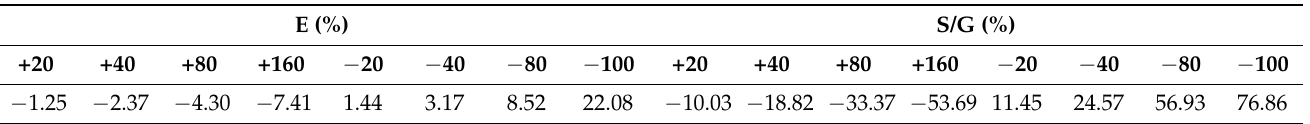
Figure 13. Changing rates of global solar irradiance (%) caused by the changes of one factor (%), while another factor was kept at its original level.